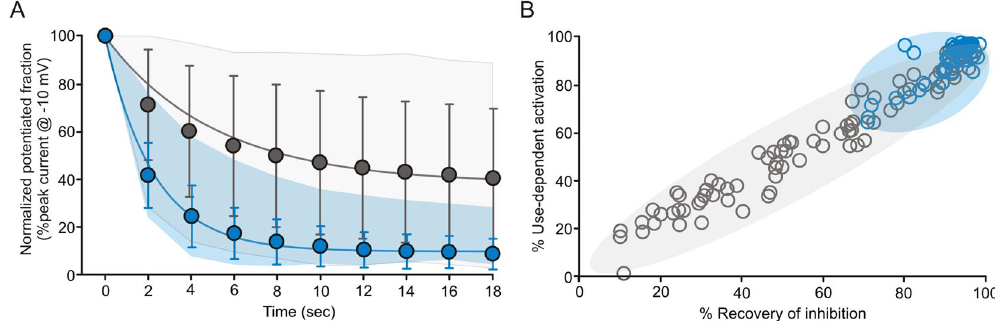
Figure 2. Time dependent recovery of inhibited gating mode. ( A ) Cells expressing Kv1.2 were stimulated with a train of repetitive depolarizations to + 60 mV, followed by a sequence of 15 ms pulses to − 10 mV (0.5 Hz) to assess recovery of the inhibited gating mode (detailed protocol in Supplemental Figure 2). Mean normalized test pulse magnitude ( ± S.D) for ambient redox (grey, time constant = 5.1 ± 2.9 s, N = 51) and DTT incubation (blue, time constant = 2.2 ± 1.0 s, N = 46) are presented, along with surfaces illustrating the range of variability observed in individual cells. ( B ) Cell-by-cell correlation of % use-dependent activation and % recovery of inhibition. Each data point reflects an individual cell (grey: ambient redox, blue: 666 µ M